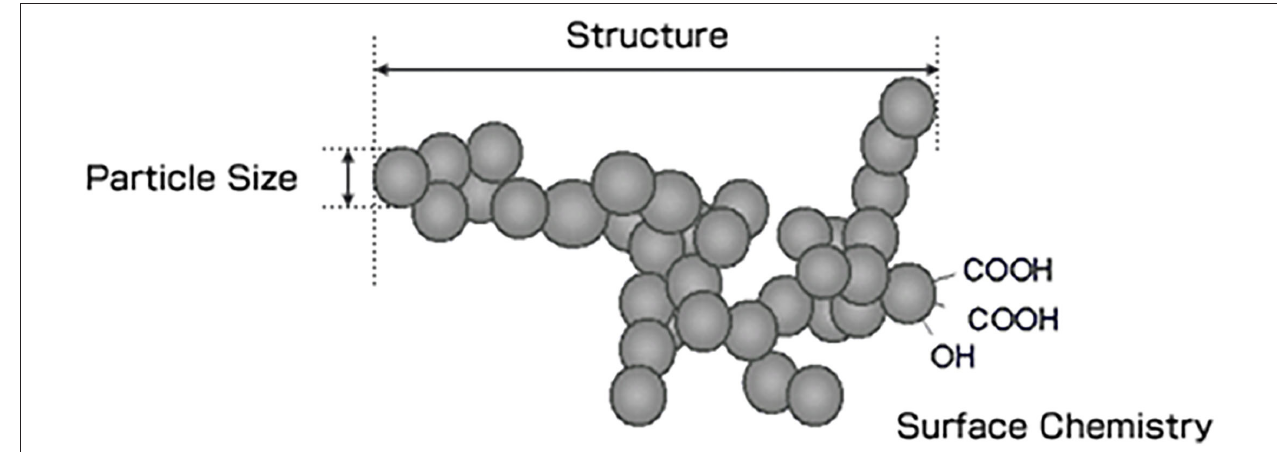
FIGURE 1 | Structure of carbon black.